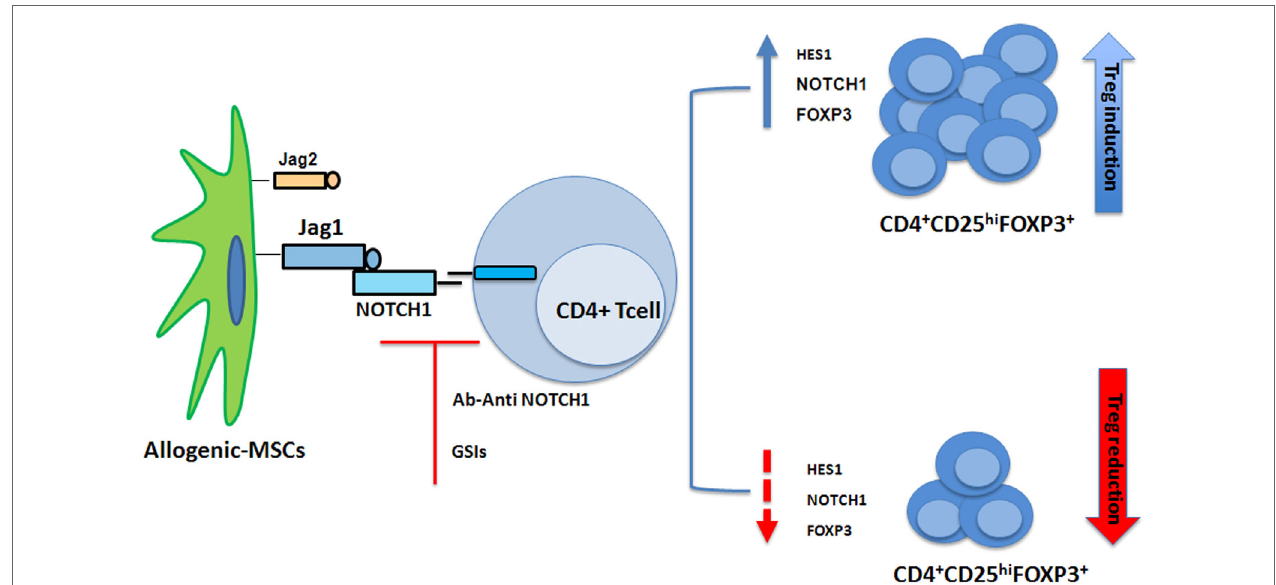
FiGURe 2 | Mesenchymal stem cells (MSCs) recruit induced Tregs (iTregs) by activating Notch signaling. When cocultured with CD4 + cells, MSCs induced a T-cell population with a regulatory phenotype (iTregs) (57). NOTCH1 pathway is activated in CD4 + T cells cocultured with MSCs. Inhibition of NOTCH1 signaling through γ -secretase inhibitor (GSI)-I or the NOTCH1 neutralizing antibody reduced expression of HES1 and the percentage of MSC-induced CD4 + CD25highFOXP3 + cells in vitro